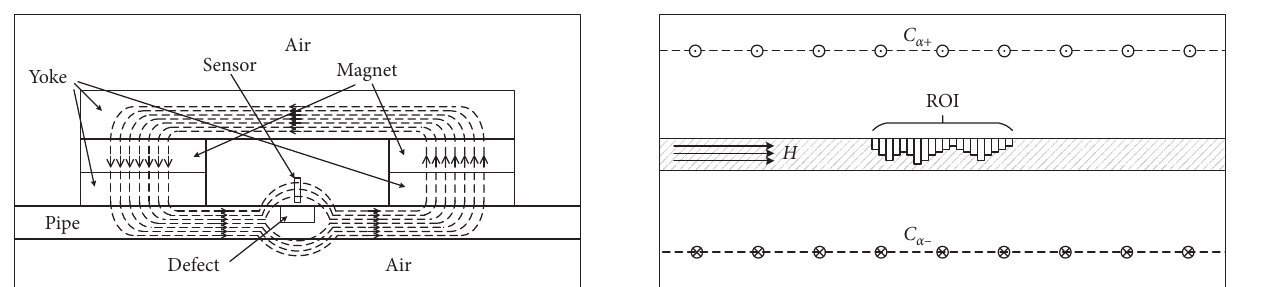
Figure 1: Principle of MFL inspection.